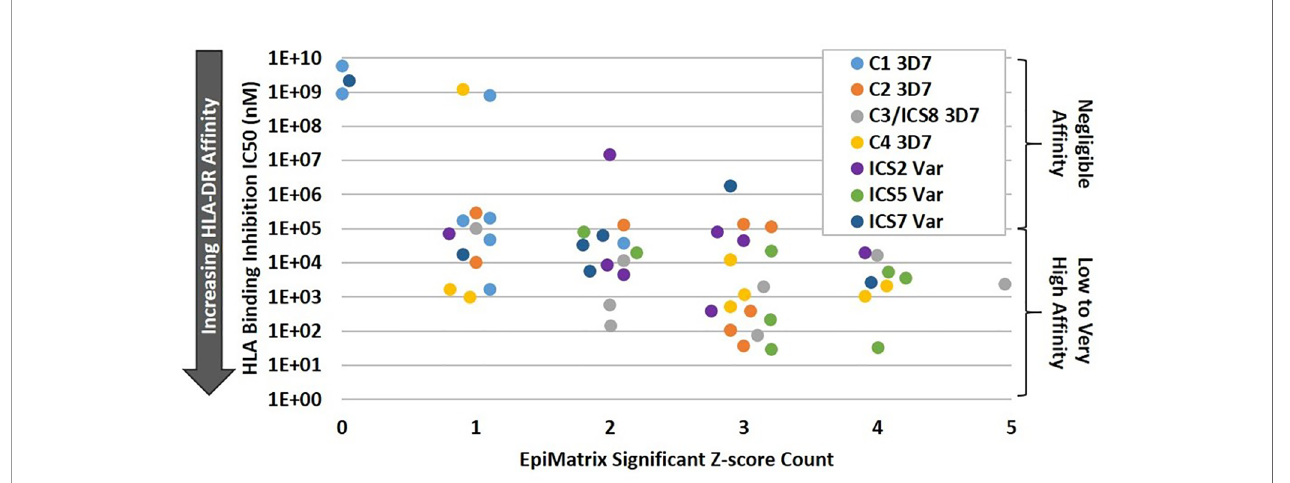
FIGURE 3 | Increasing HLA-DR Allele Binding Af fi nity Trends with Increasing EpiMatrix Signi fi cant Z Score Count. For the class II clusters C1-C4, ICS2, ICS5, and ICS7, in vitro HLA binding af fi nity to DR1, DR3, DR4, DR8, DR11, DR13, and DR15 alleles was plotted against the number of in silico predicted epitopes for